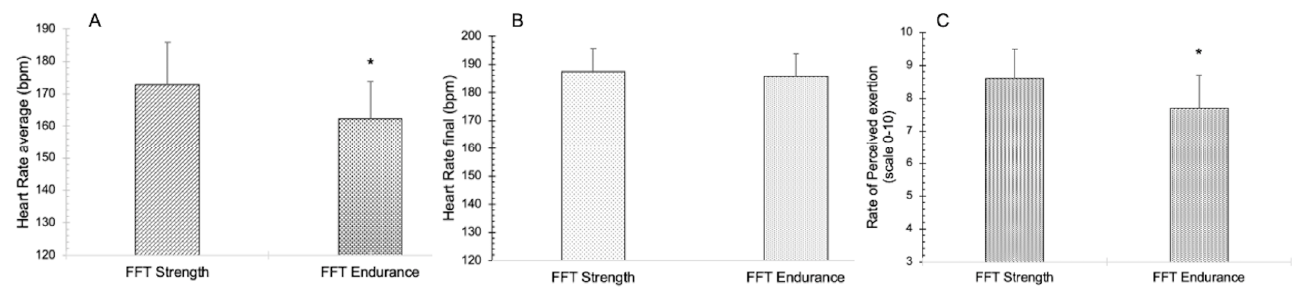
Figure 3. Comparison between FFTs for the variables Heart Rate average ( A ), Heart Rate final ( B ), and Rate of Perceived Exertion ( C ); bpm = beats per minute; * = significant difference ( p < 0.05). For MVP at 1 m·s −1 Squat Test, MVP at 1 m·s −1 Military Press Test and blood lactate,